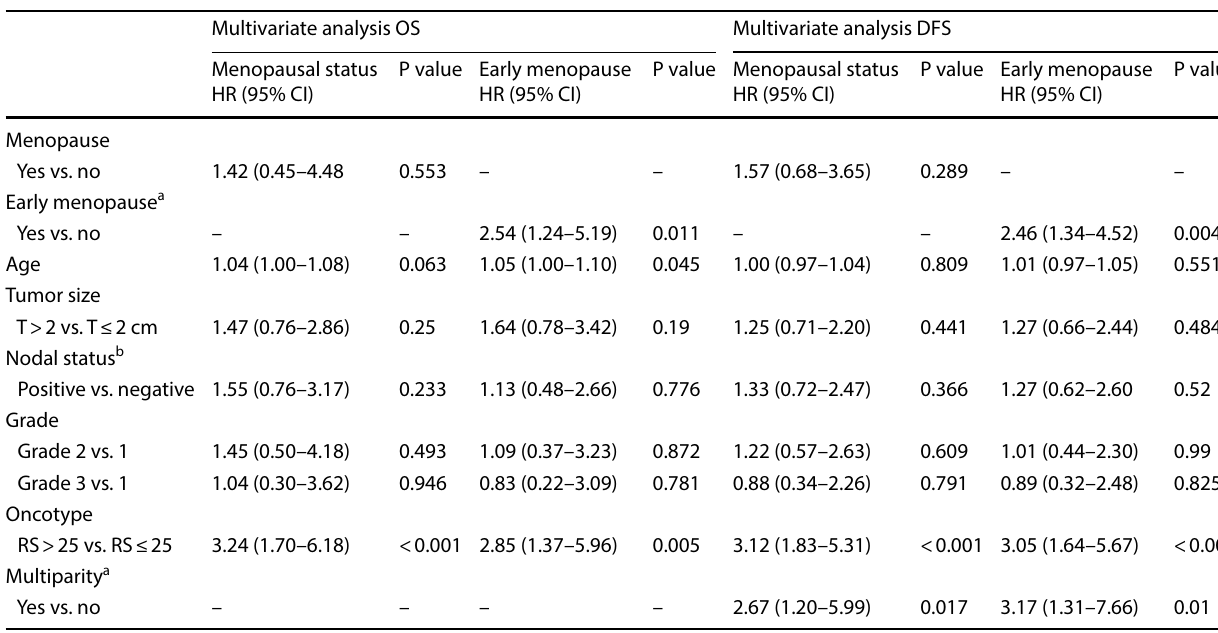
Table 3 Multivariate analysis for OS and